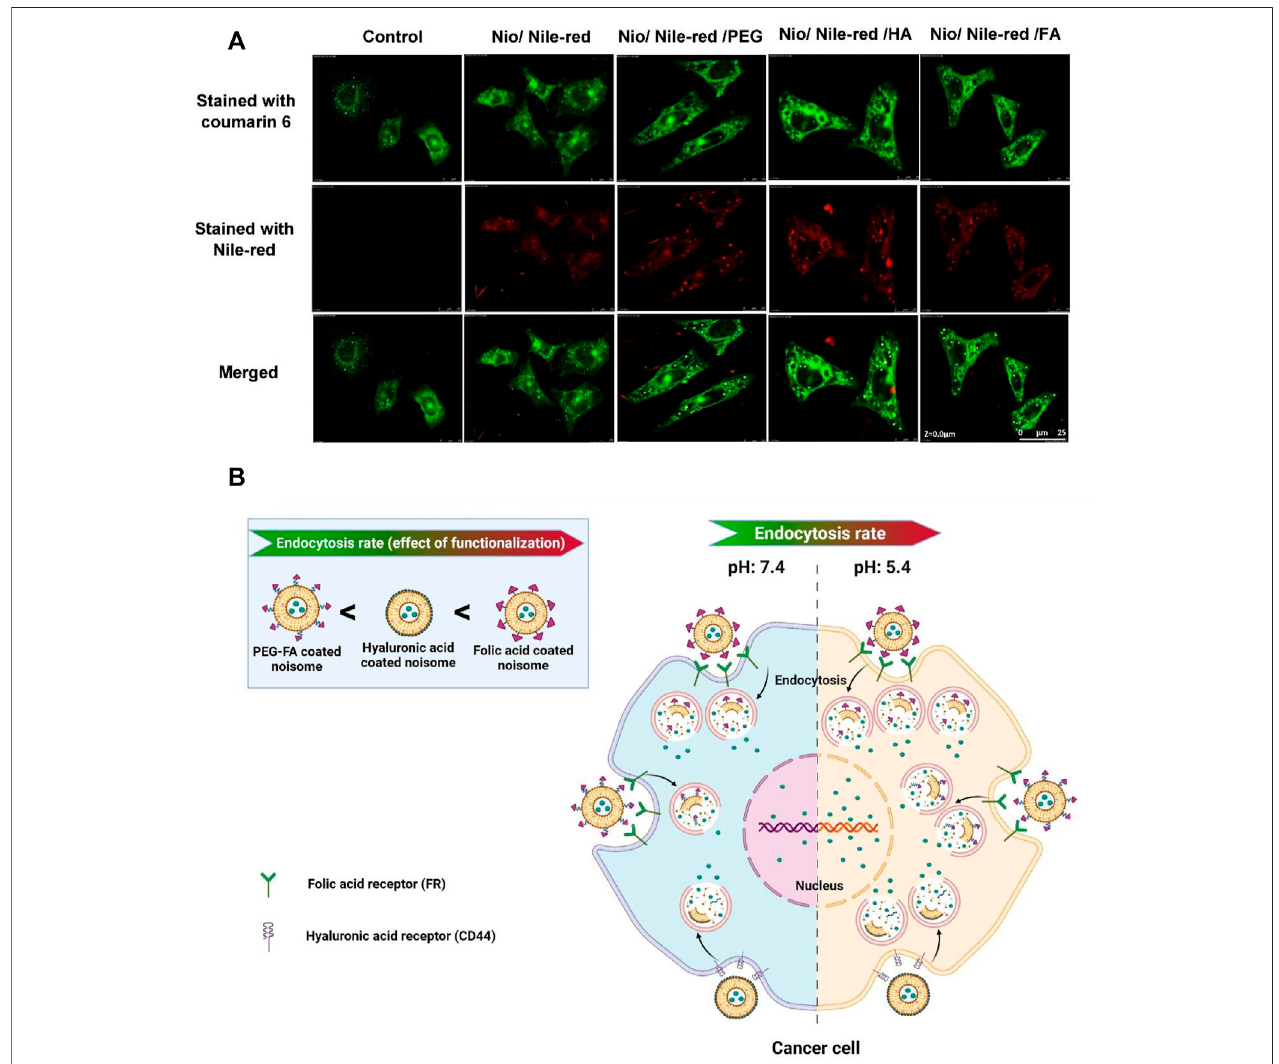
FIGURE 8 | The uptake of niosomes in MCF7 cells was investigated with confocal laser scanning microscopy. The niosomes investigated were: Nio/5-FU, Nio/5- FU/PEG,Nio/5-FU/HAandNio/5-FU/FA. (A) RepresentativeCLSMimagesofMCF7cellsstainedwithcoumarin6andNile-red. (B) SchematicdepictingtheeffectofpH on the release of contents from a